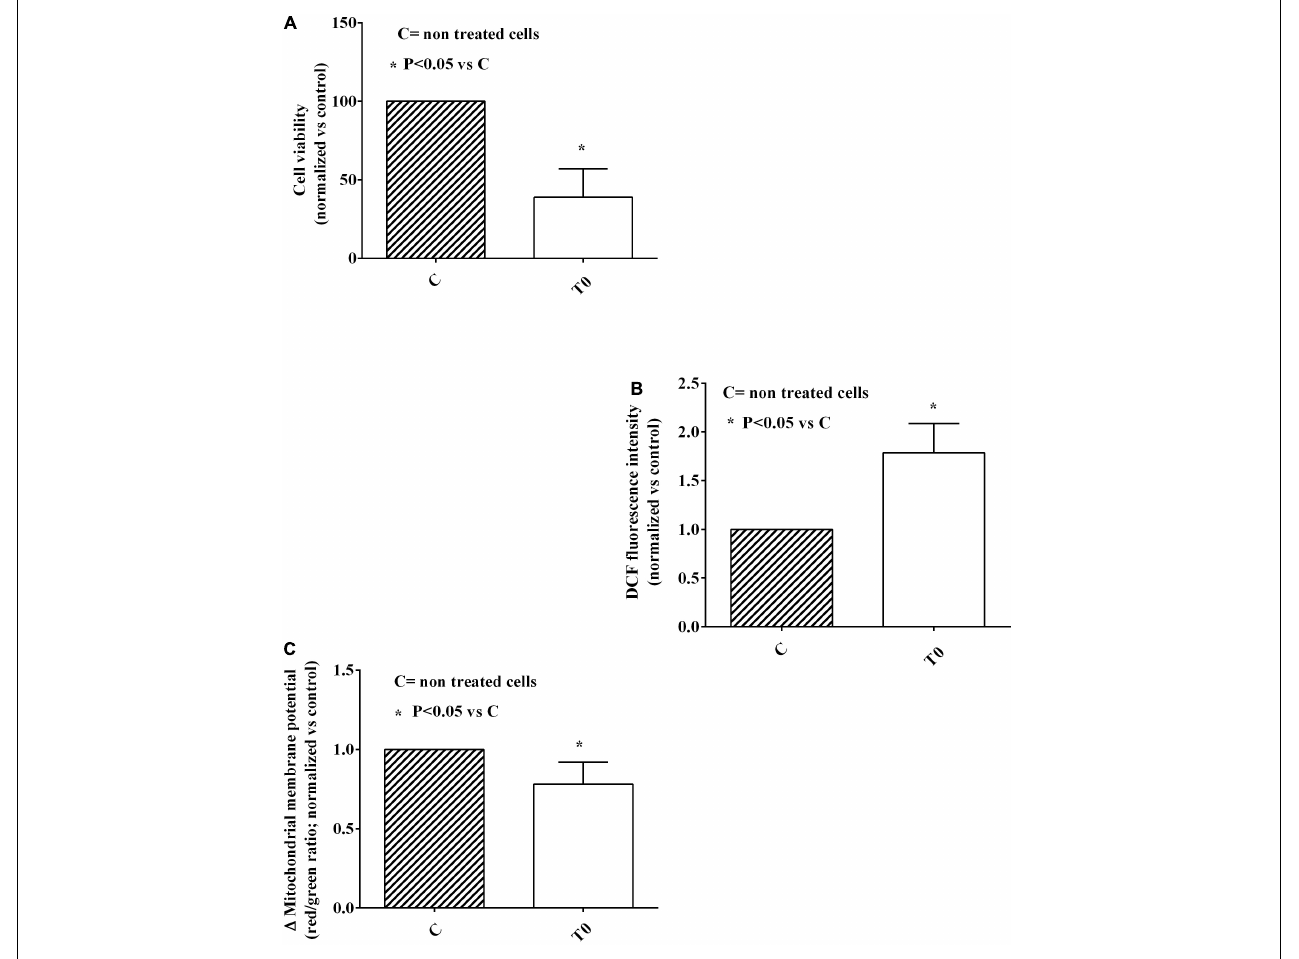
FIGURE 1 | Effects of plasma of the elderly on cell viability (A) , reactive oxygen species (ROS; B ) release, and mitochondrial membrane potential (C) in HUVEC. The results are means ± SD of three different experiments performed in triplicate. DCF, 2,7-dichlorodihydrofluorescein; T0, baseline. *Means P < 0.05 vs